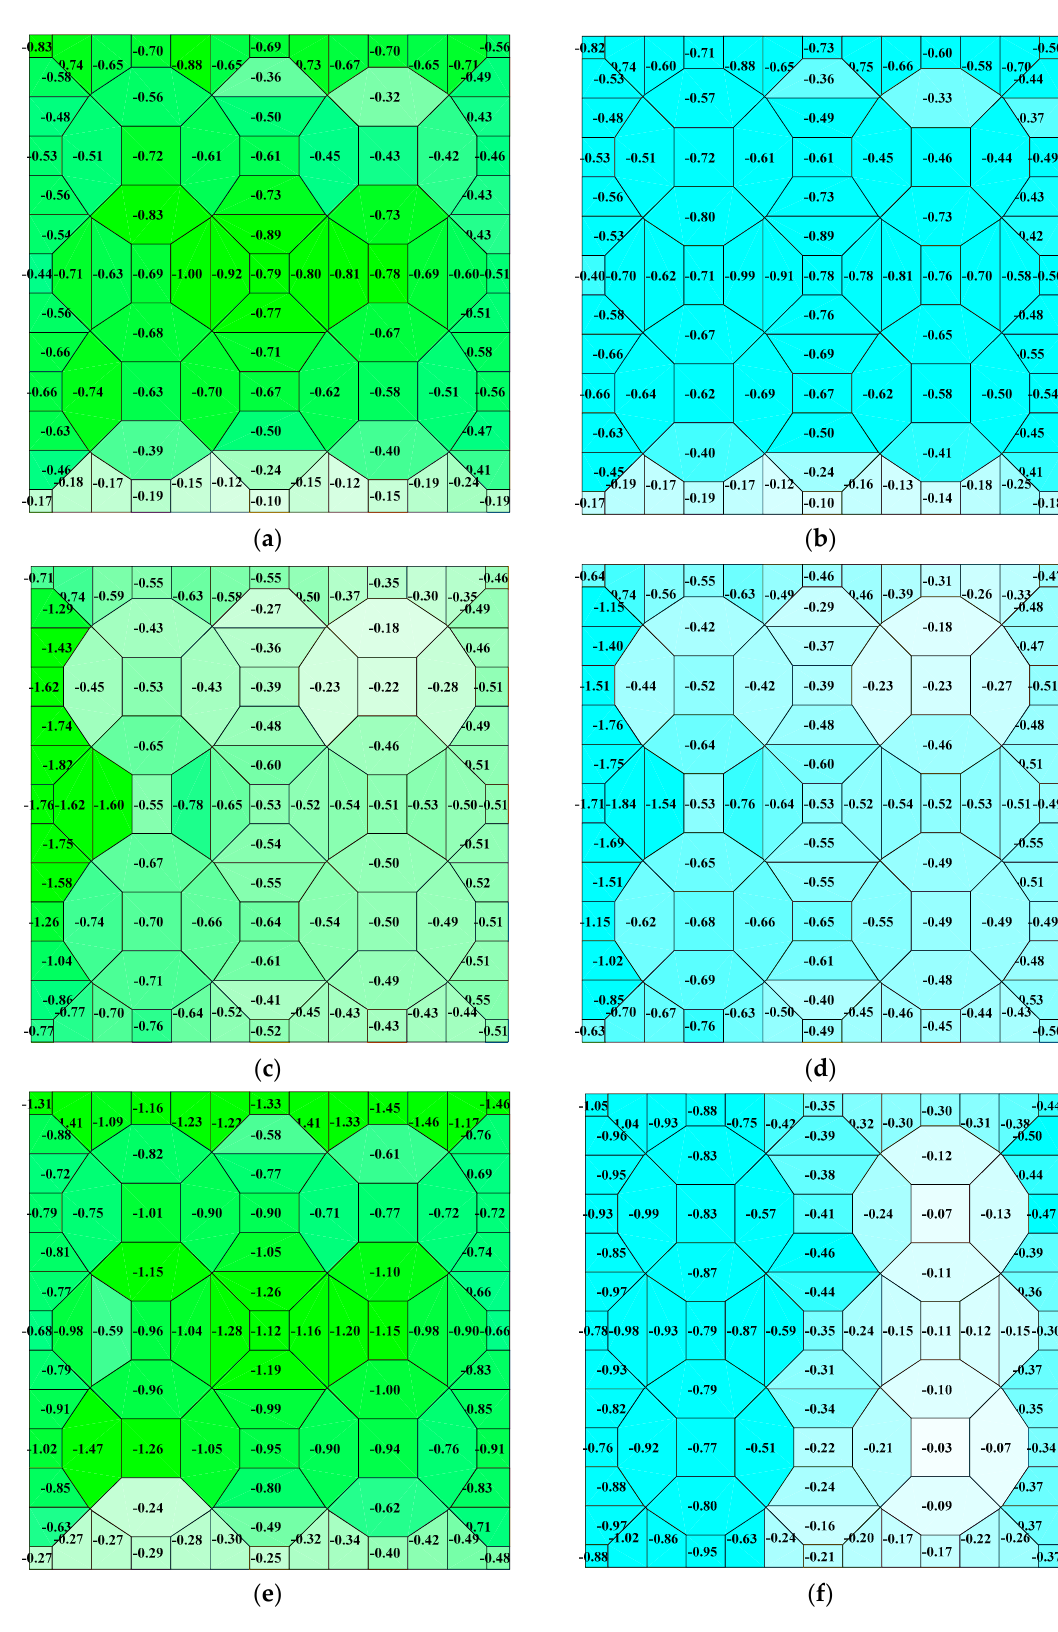
Figure 9. Model 3, mean pressure coefficient maps for α = 0° ( a ), α = 45° ( c ), and α = 90° ( e ); maps using mode of pressure coefficients for α = 0° ( b ), α = 45° ( d ), and α = 90° ( f ).